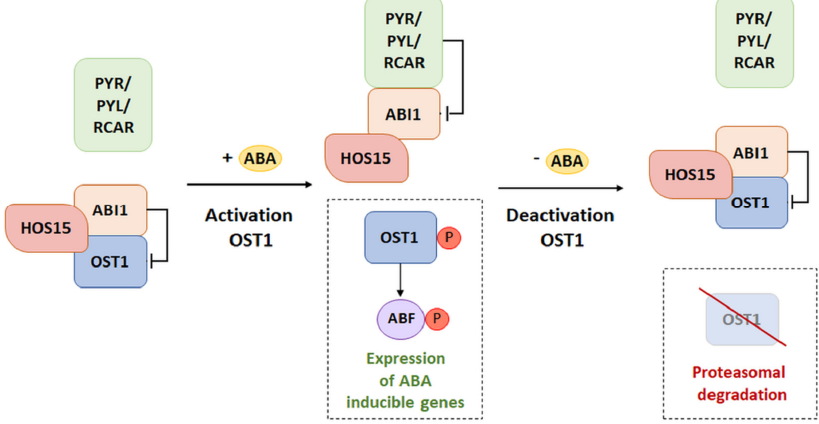
Figure 7. Inhibitory effect of HOS15-ABI1 on the ABA transduction pathway by degradation of OST1. PYR/PYL/RCAR: ABA receptors, ABI1: type 2C protein phosphatase (negative regulator), OST1: SnRK2 kinase (positive regulator), HOS15: receptor for an E3 ligase-linked ubiquitin mole- cule, ABF: ABRE binding factor, P: phosphorylation. (Modified from